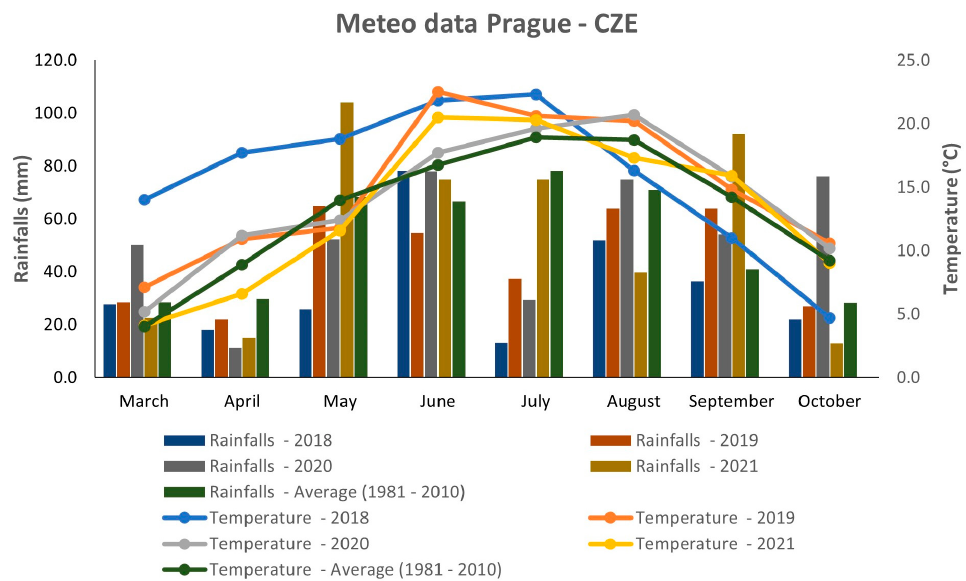
Figure 1. Weather conditions in 2018–2021 in Prague, Czech Republic.